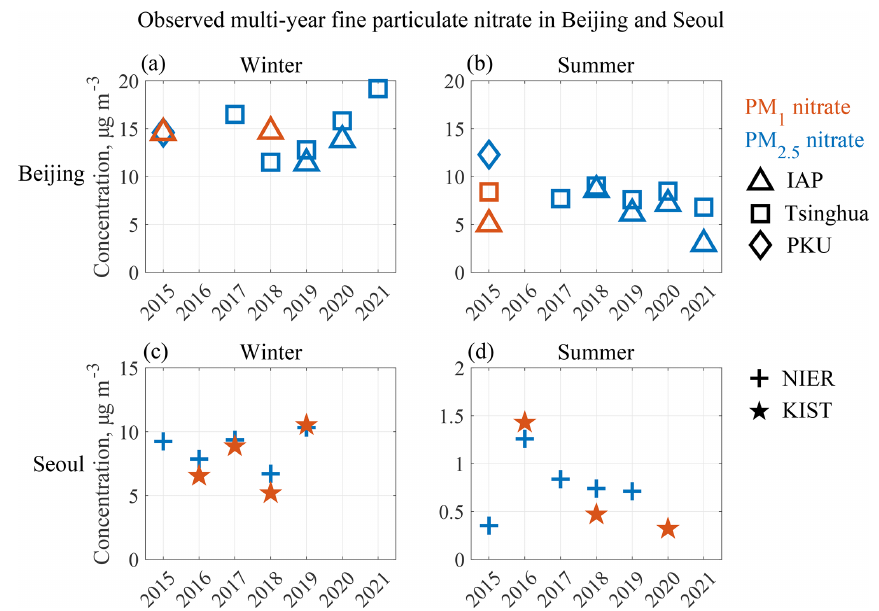
Figure 5. Long-term trend of fine particulate nitrate concentrations in Beijing and Seoul over the 2015–2021 period. Mean PM 1 or PM 2 . 5 concentrations in winter and summer are compiled from individual field campaigns in Beijing at the Institute of Atmospheric Physics (IAP), Tsinghua University (Tsinghua), and Peking University (PKU) sites and in Seoul at the National Institute of Environmental Research (NIER) and Korea Institute of Science and Technology (KIST) sites (Table S1). Note the differences in scales between